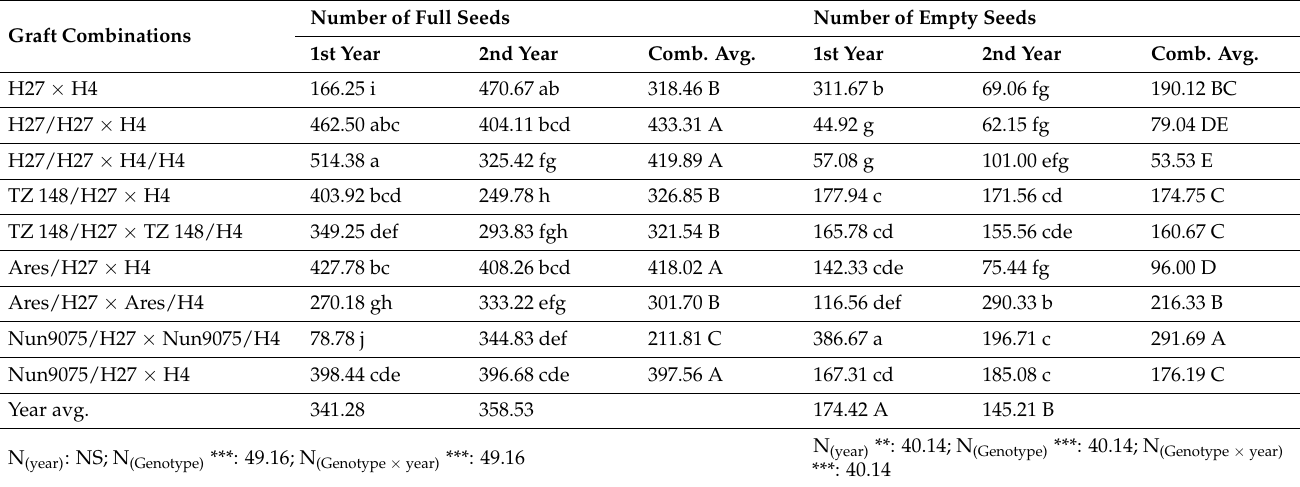
Table 7. Number of full seeds and empty seeds obtained of different graft combinations in both